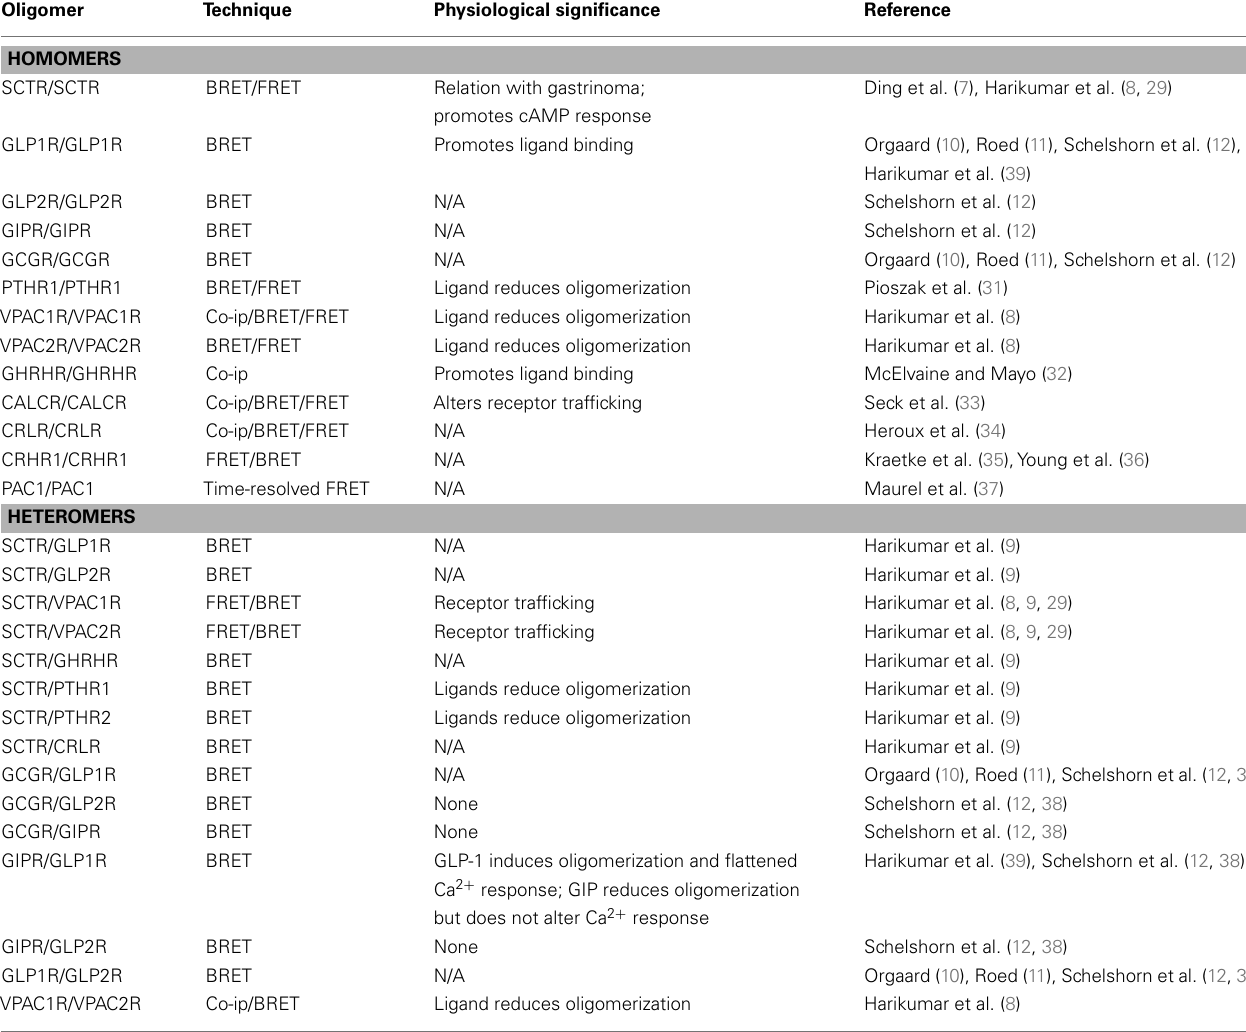
Table 1 | Oligomerization of intra-family family B GPCRs